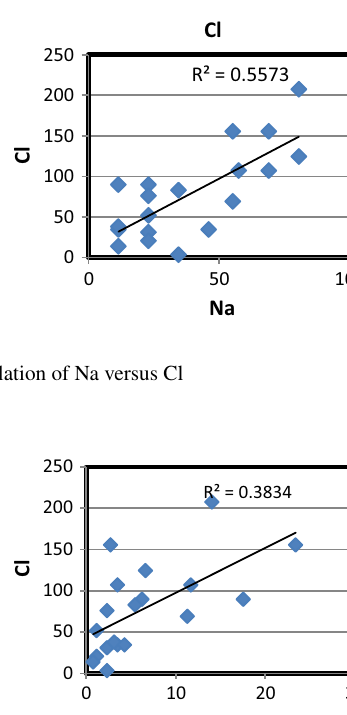
Fig. 3 Correlation of K versus